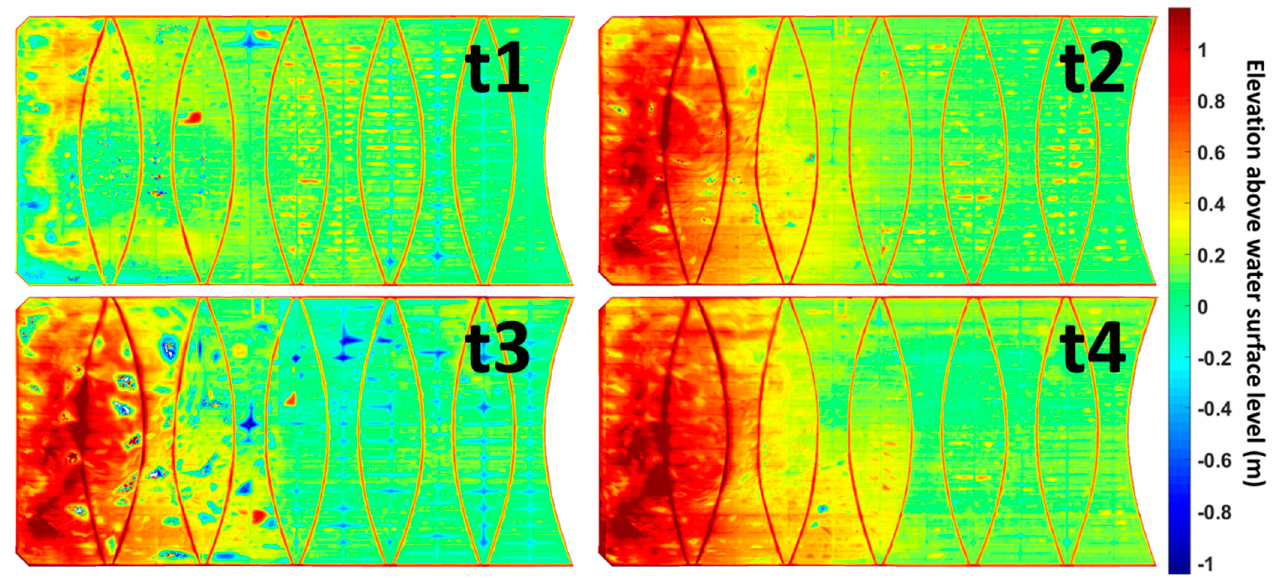
Figure 10. Digital elevation model of floating cover from t1 to t4.